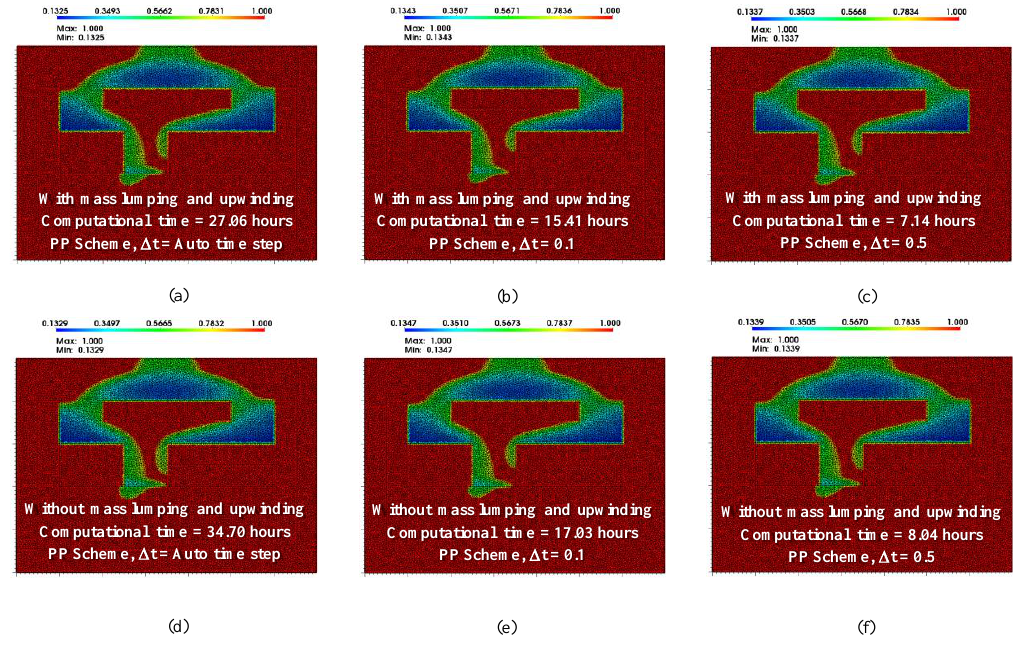
Figure 9. Comparison of predicted tetrachloroethylene distribution in terms of the liquid at 313 Sec: ( a – c ) with the mass lumping and the upwinding and ( d – f ) without the mass lumping and the upwinding.